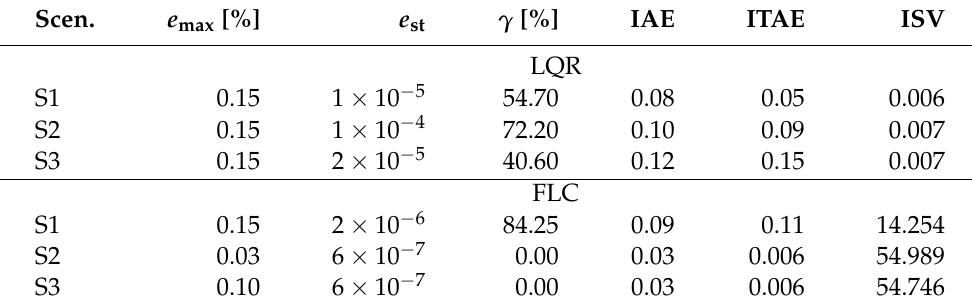
Table 6. Quality indexes of the LQR and FLC—Area 1.